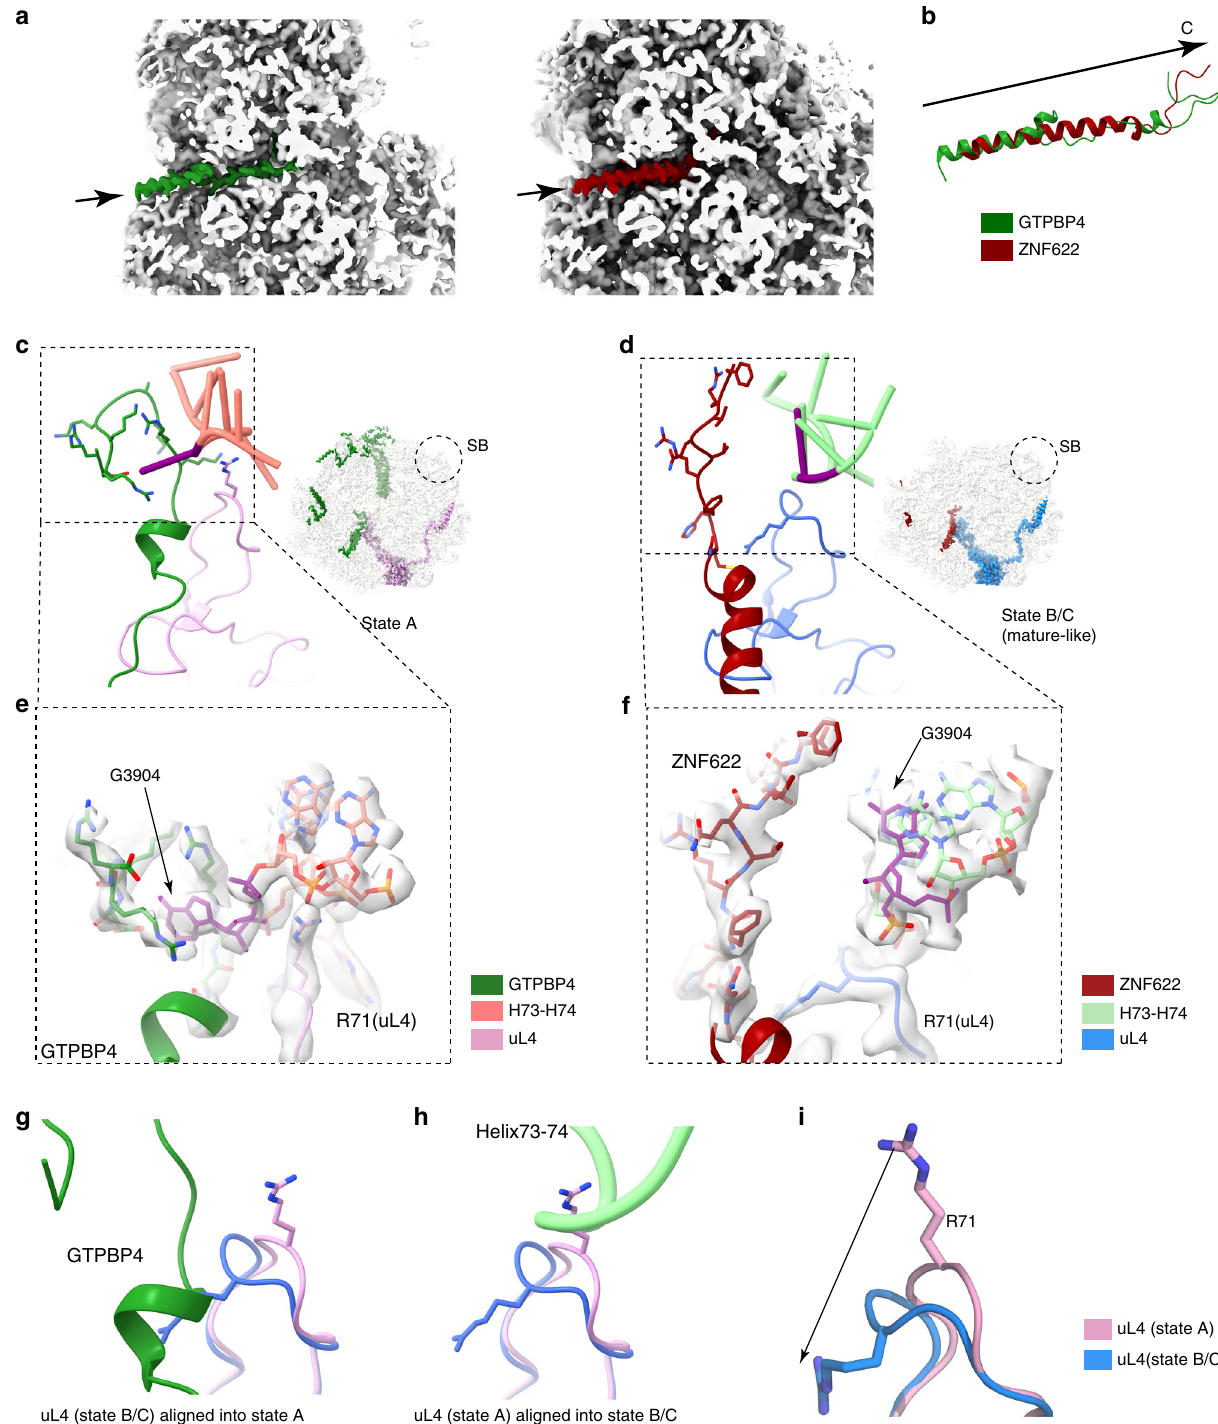
Fig. 5 Insertion of the C-terminal tails of GTPBP4 and ZNF622 in the PET. a Cross-section views showing the insertion of the C-terminal tails of the two factors into the PET of the pre-60S structures (GTPBP4 in state A, ZNF622 in state B/C). The peptide tunnel exit is labeled by an arrow. b Superimposition of C-terminal tails of GTPBP4 and ZNF622 in the same view as in a . c , d , The C-terminal end of two factors interact with the PTC-PET components (H73- H74 linker and uL4) in state A ( c ) and state B/C (mature like, d ) respectively. e , f , Zoom-in views on H73-H74 linker related to ( c ) and ( d ). The C-terminal ends of GTPBP4 and ZNF622 are shown in stick models. Conformation change of G3904 in two states are highlighted. g , h , Superimposition of uL4 in GTPBP4-bound and ZNF622-bound states. The mature position of R71 (blue, state B/C) clashes with GTPBP4 ( g ), whereas its immature conformation (pink, state A) is incompatible with H73-74 ( h ). i Structural comparison of the conserved loop in uL4 in the two states. R71 in the loop is